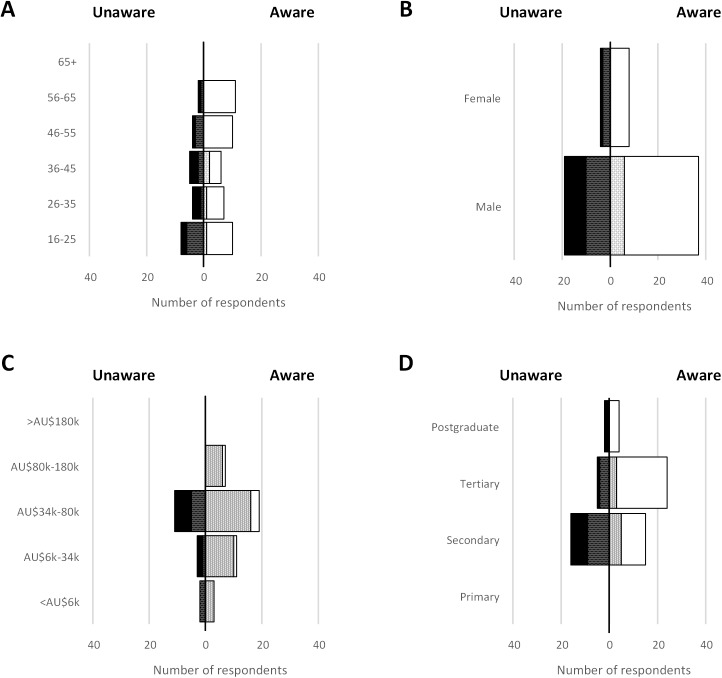
Survey respondent distribution for A) Age, B) Gender, C) Income; and D) Education with self-declared “unaware” respondents to the left (black and dark stipple) and “aware” respondents to the right (white and light stipple). Solid (black and white) represents accurate recognition of at least two NIMS; stippled (dark stipple and light stipple) represents accurate recognition of less than two NIMS.